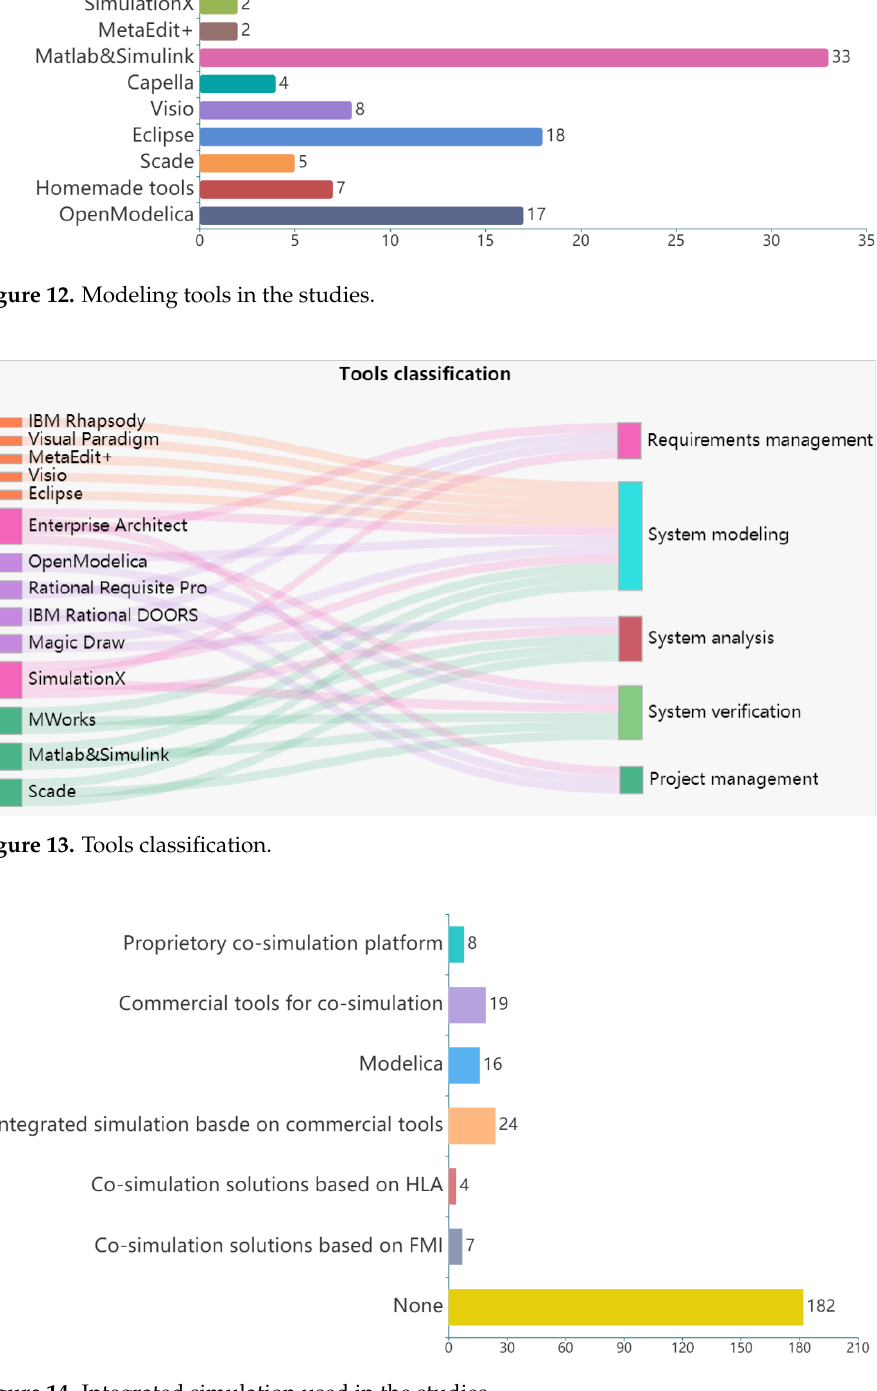
Figure 14. Integrated simulation used in the